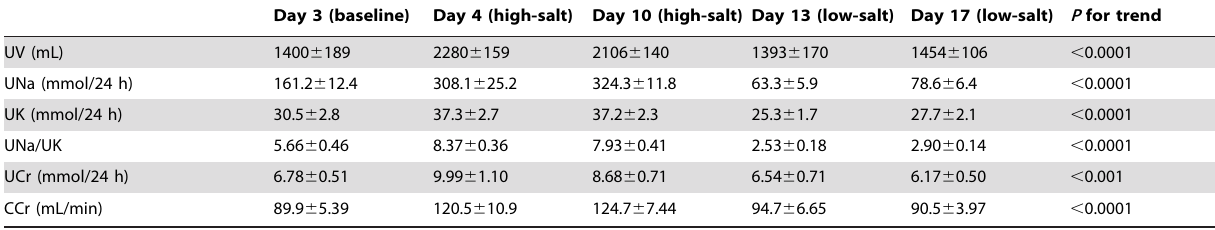
Table 3. 24-h Urinary Parameters and Creatinine Clearance during Dietary Intervention (n=